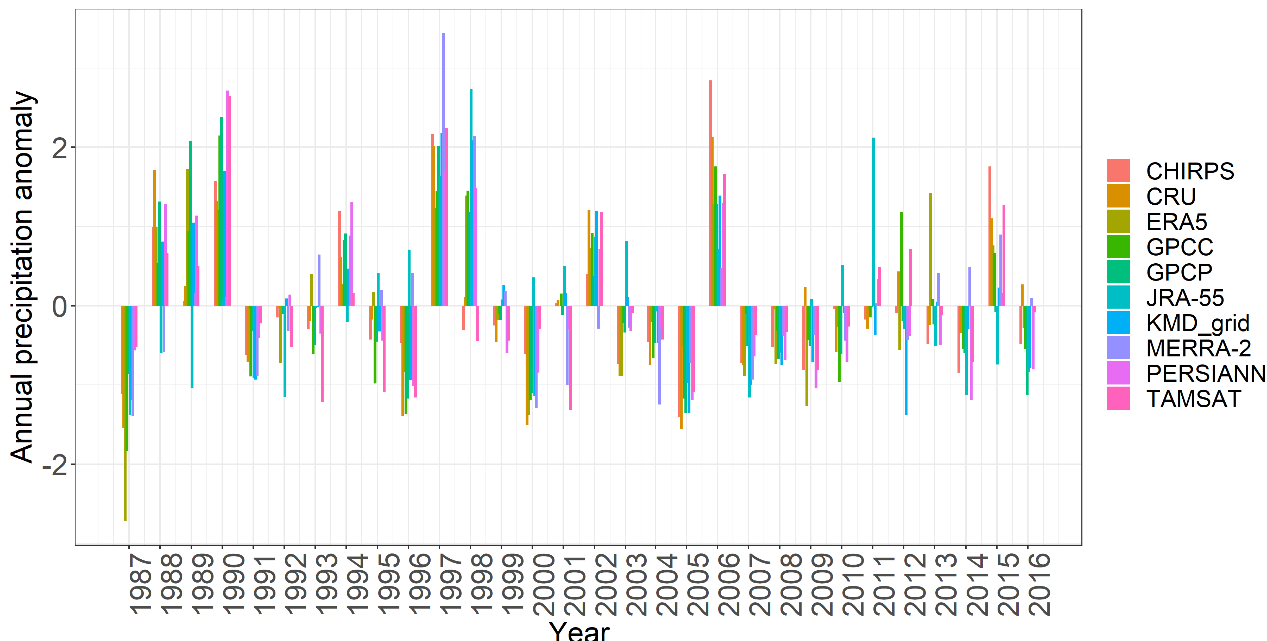
Figure 2. Annual precipitation anomalies as conveyed by the different data products.